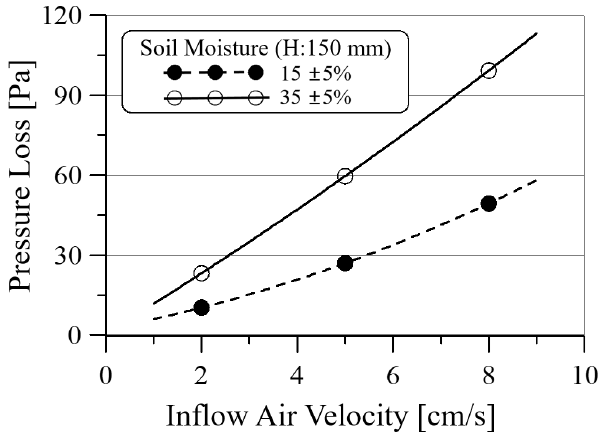
Figure 7. Pressure loss for two soil moisture at the soil height of 150 mm (“H” in Figure 1) with respect to inflow air